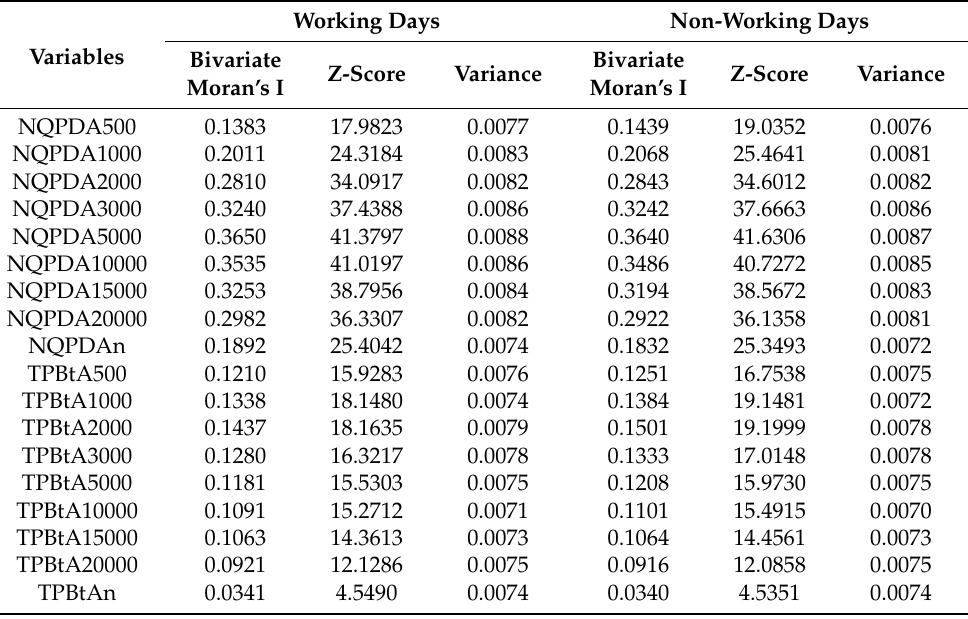
Table 3. Calculation results of bivariate Moran’s I between the TOI of taxi drivers and road network topological